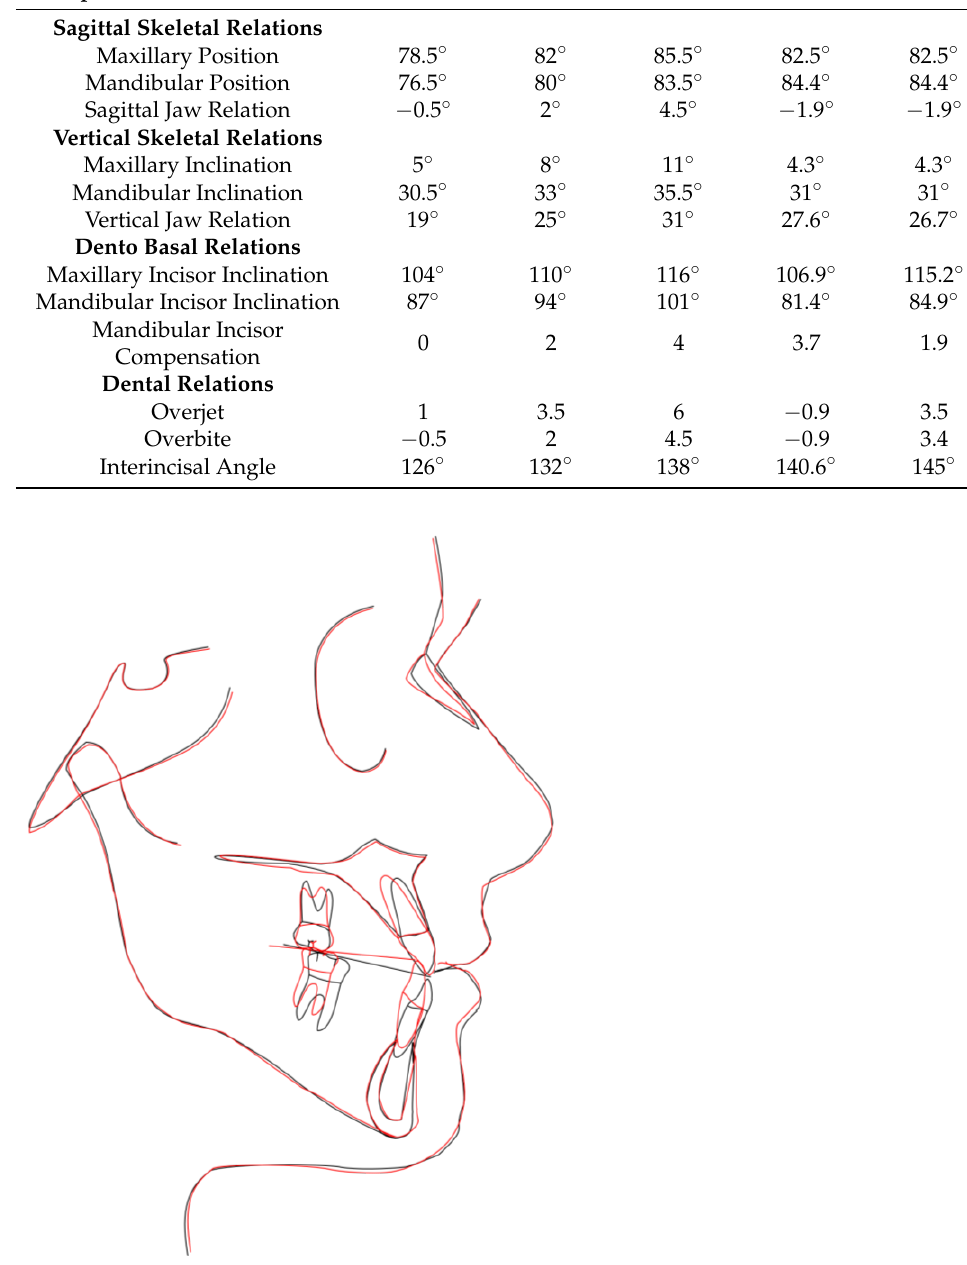
Table 2. Final cephalometric values.